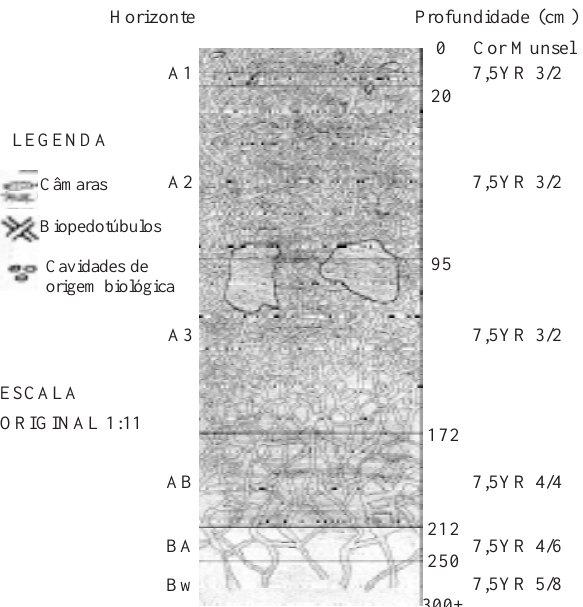
Figura 9. Arranjo dos biopedotúbulos e cor dos horizontes do Latossolo Húmico (P2).